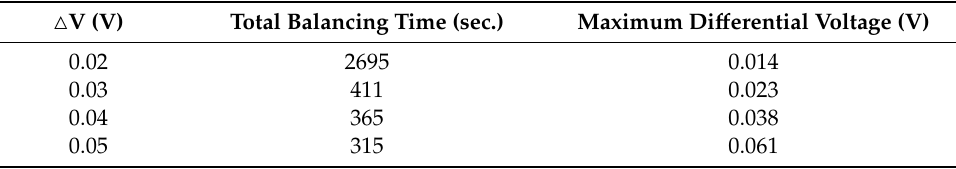
Table 6. Comparison of di ff erent single (cid:52) V for a complete balancing